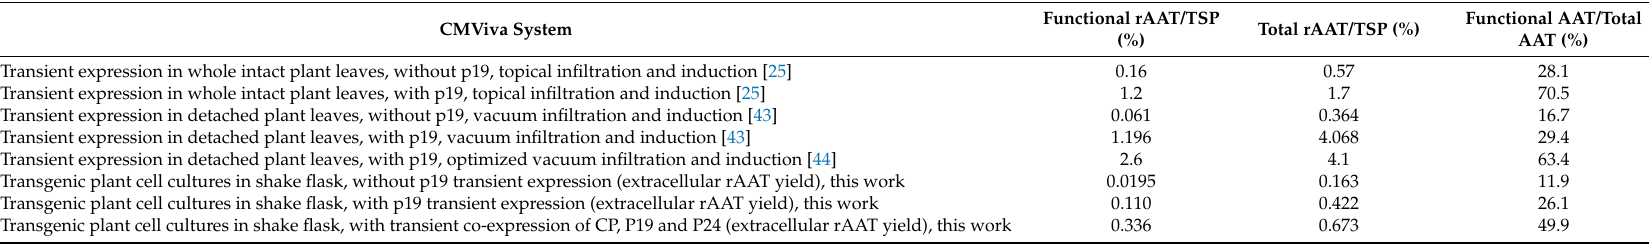
Table 4. Comparison of rAAT production in N. benthamiana using the CMViva system following induction in N. benthamiana leaves through Agrobacterium -mediated transient expression and transgenic N. benthamiana cell cultures. TSP = total soluble